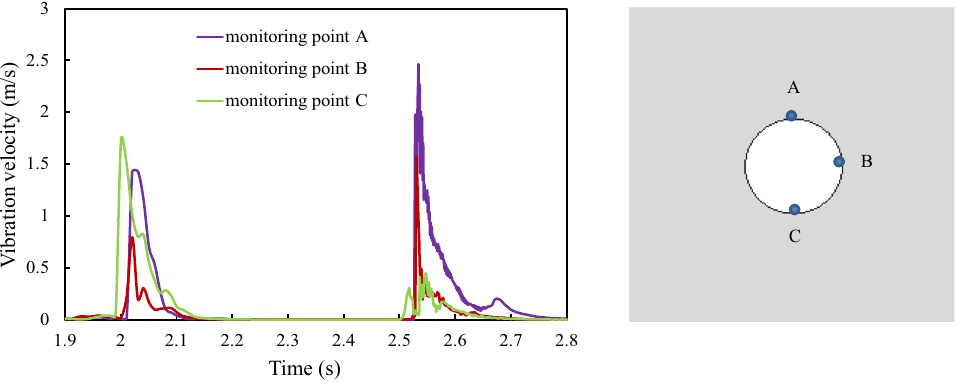
Fig. 8 Vibration velocity–time evolution curves for three monitoring points in different locations of cavern (dynamic disturbances in vertical